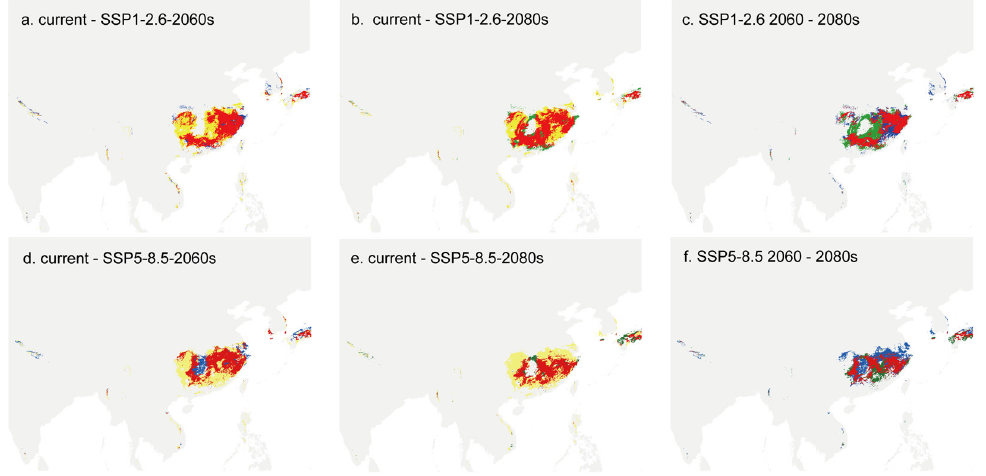
Figure 6. Prediction of potential distribution areas of A. cordatum in LIG ( a ), LGM MIROC ( b ), LGM CCSM ( c ), Current ( d ), SSP1-2.6-2060s ( e ), SSP1-2.6-2080s ( f ), SSP5-8.5-2060s ( g ), and SSP5-8.5-2080s ( h ) by MaxEnt. LIG: Last interglacial; LGM MIROC: Model for Interdisciplinary Research on Cli- mate Earth System Model of the Last Glacial Maximum; LGM CCSM: Community Climate System Model of the Last Glacial Maximum.